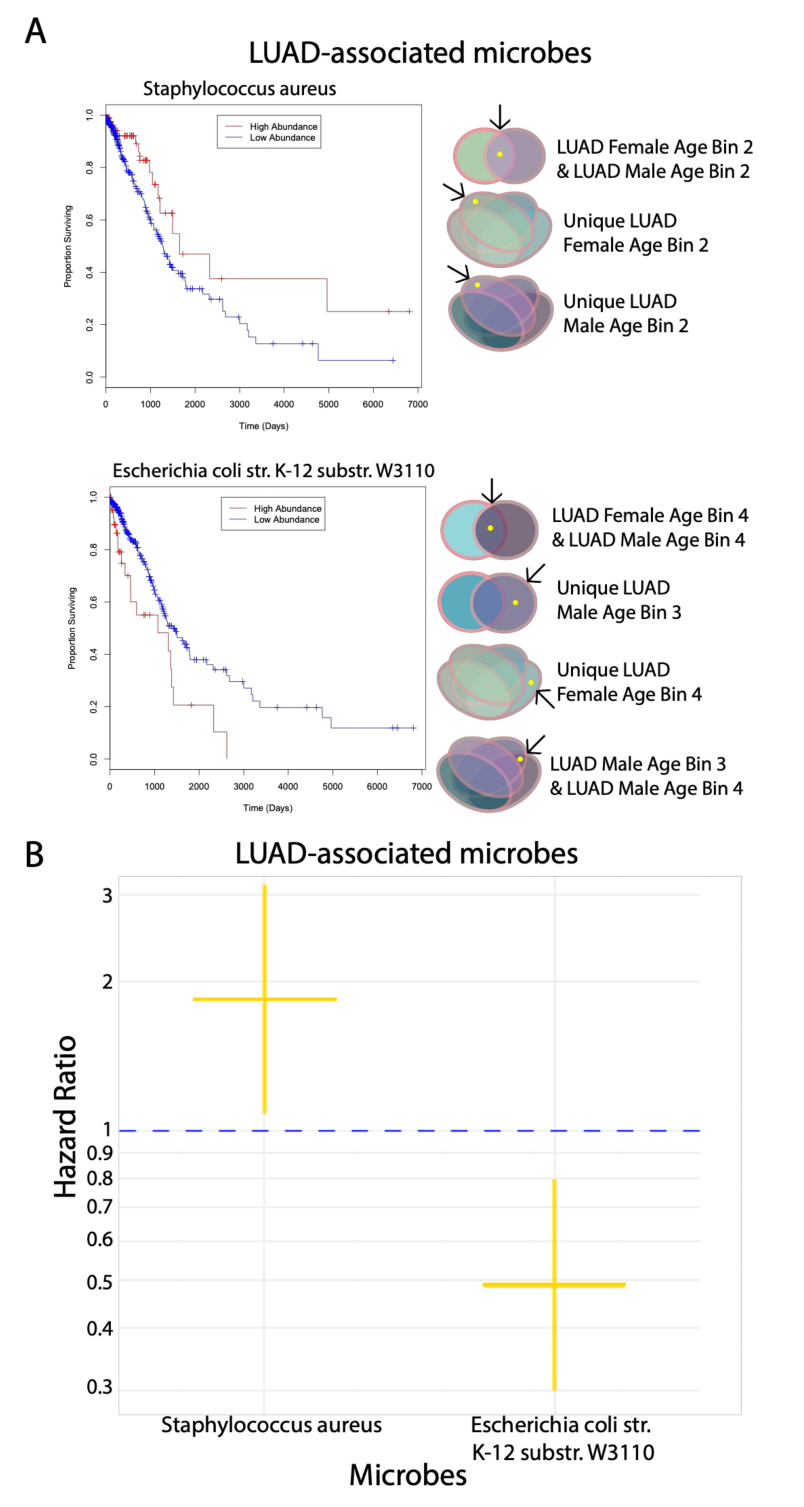
Figure4. Correlationofdi ff erentiallyabundantmicrobesinLUADtopatientsurvival. ( A )Kaplan–Meier plots of di ff erentially abundant microbes in LUAD. The comparisons and cohorts that these microbes are associated with are shown to the side. ( B ) Hazard ratio plot of di ff erentially abundant microbes in LUAD. Above the cut-o ff of 1 demonstrates that lower expression of the microbe correlates with lower patient survival, while below the cut-o ff of 1 demonstrates that the lower expression of the microbe correlates to greater patient